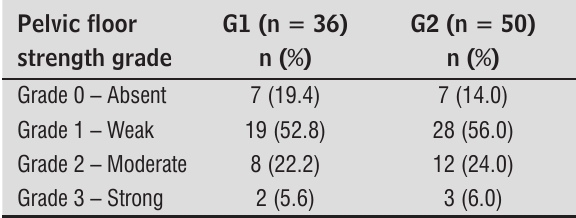
Table 2 - Pevic Floor strength of women on reproductive age (G1) and on postmenopausal period (G2)